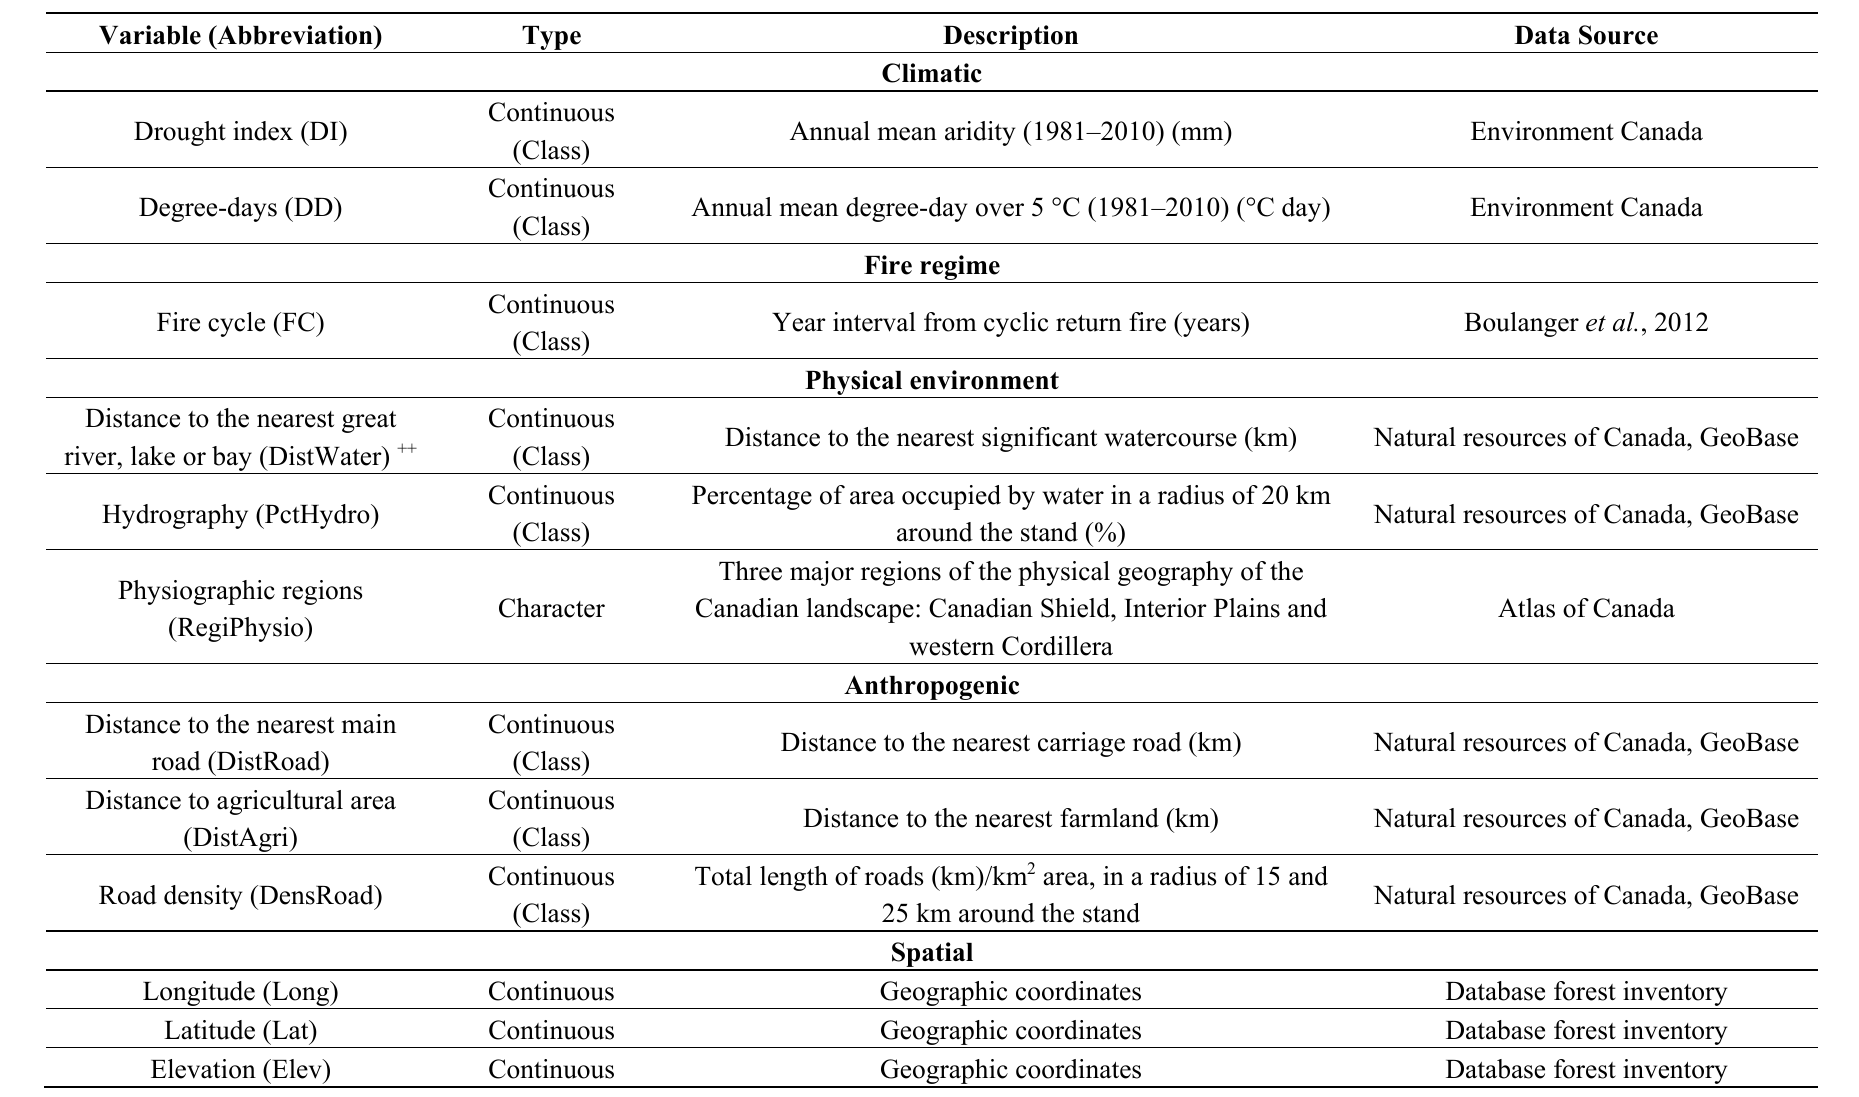
Table 2. Types and description of predictive variables used in the